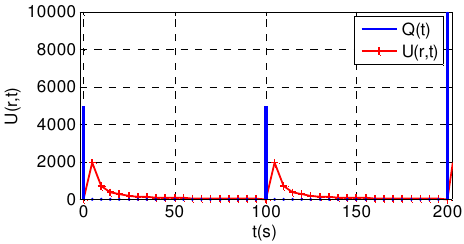
Fig. 1. Uniform temporal sampling in